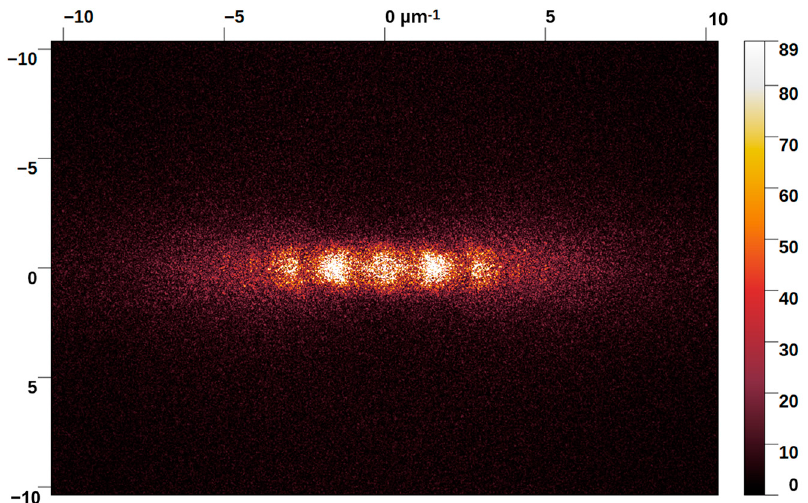
Figure 5. 2D − FFT spectrum obtained by analysing a 30 × 30 µ m 2 SEM micrograph of sample P50.